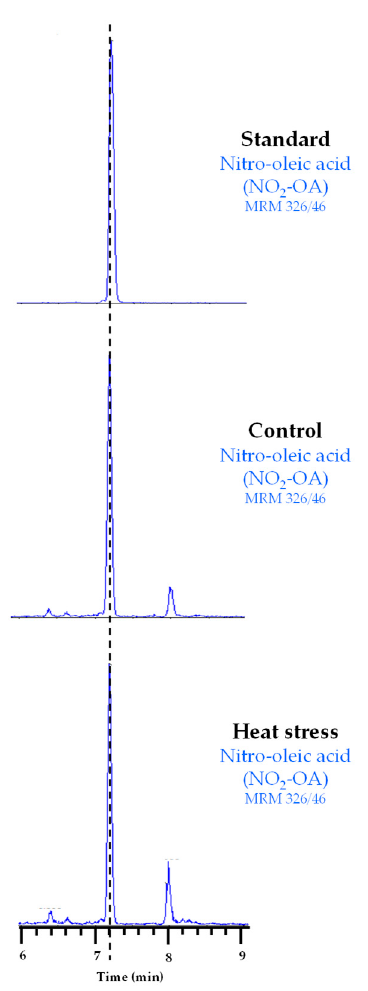
Figure 2. Chromatographic peaks corresponding to the NO 2 -OA standard and its endogenous detection in control and heat stress yeast samples. The dotted vertical line indicates the peaks with the same retention